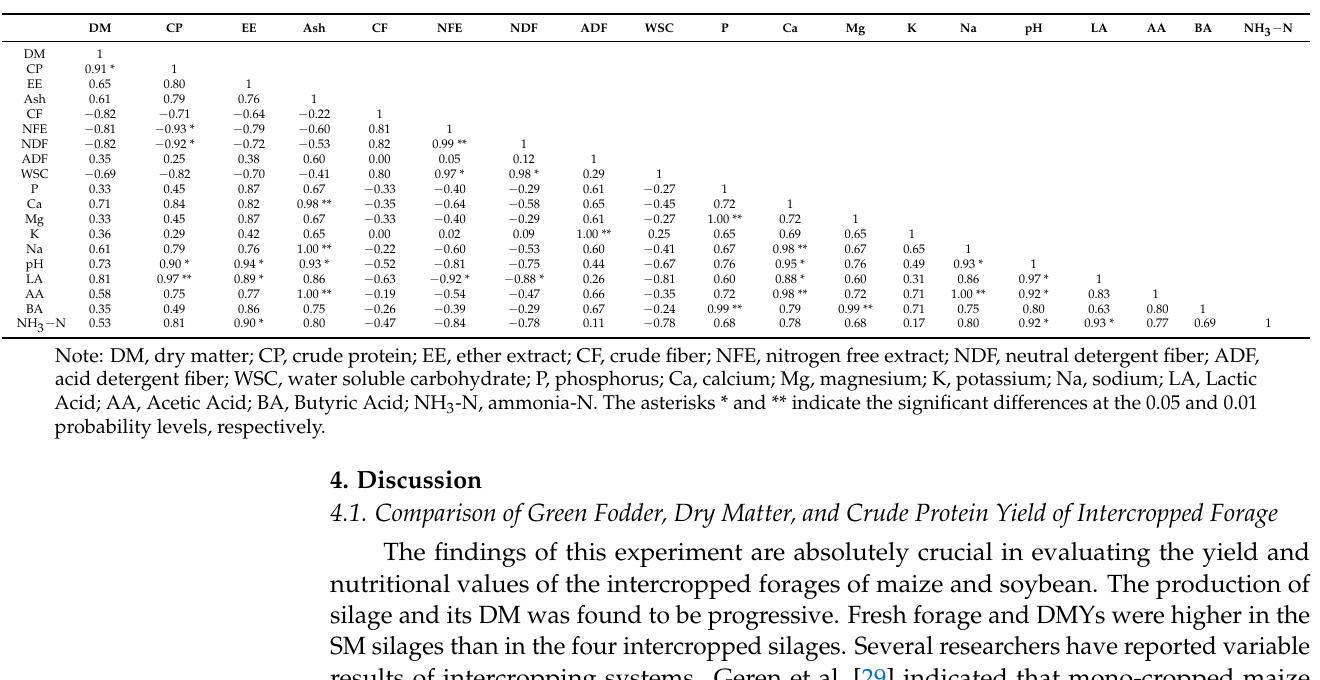
Table 5. Pearson’s correlation coefficient between nutritional and fermentational compositions of forage and silage of maize and intercropped maize-soybean on dry matter basis (% DM) of two maturity